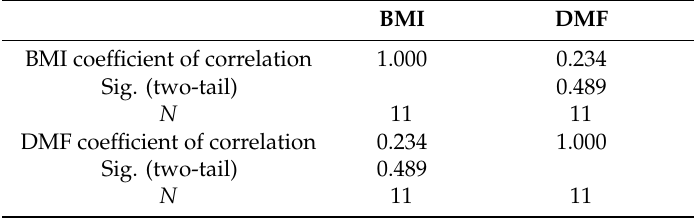
BMI DMF − 0.289 1.000 0.136 28 − 0.289 1.000 0.136